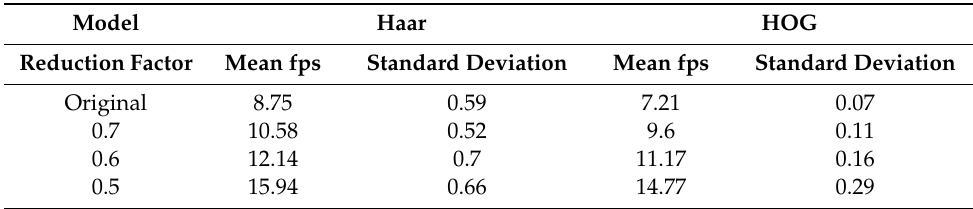
Table 3. Performance obtained with fps enhancement strategies.